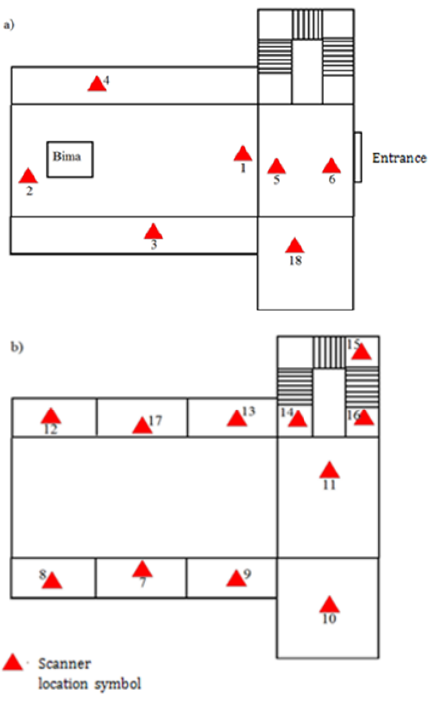
Figure 1. Diagram showing the location of measurement stations in the interior of the synagogue: a) on the ground floor, and b) on the balconies